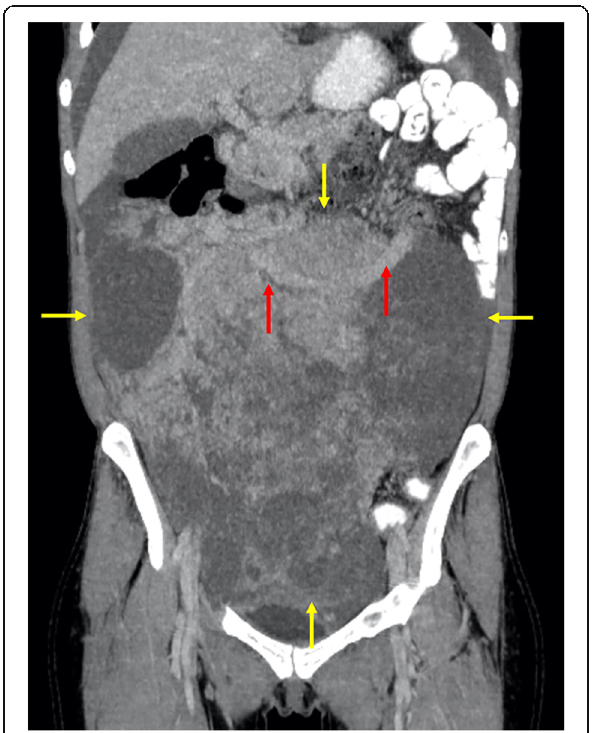
Fig. 7 Coronal post-contrast MDCT image of the entire intraperitoneal tumour (yellow arrows), highlighting the main vascular source (red